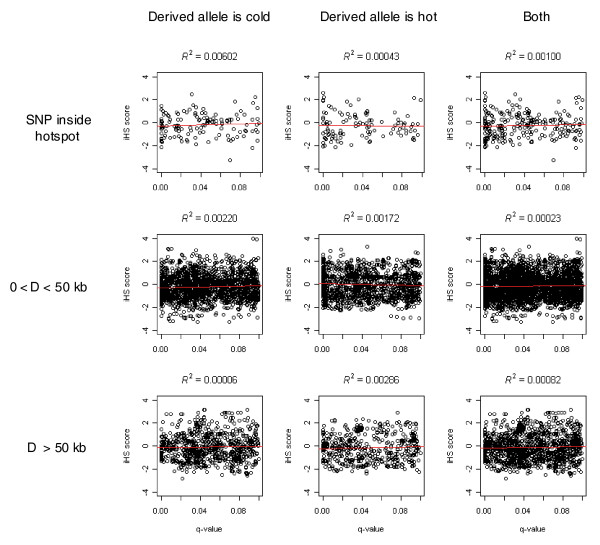
Scatter plots between LDsplit's q-values that are less than 0.1 and Haplotter's iHS scores. The three columns are, respectively, hotspot-SNP pairs where the SNP-derived allele is cold, hot, and both; the three rows correspond to three ranges of hotspot-SNP physical distances D. The red line in each panel is the least square regression line, and R2 at the top is the coefficient of determination, measuring the fraction of variance of iHS scores explained by q-values.